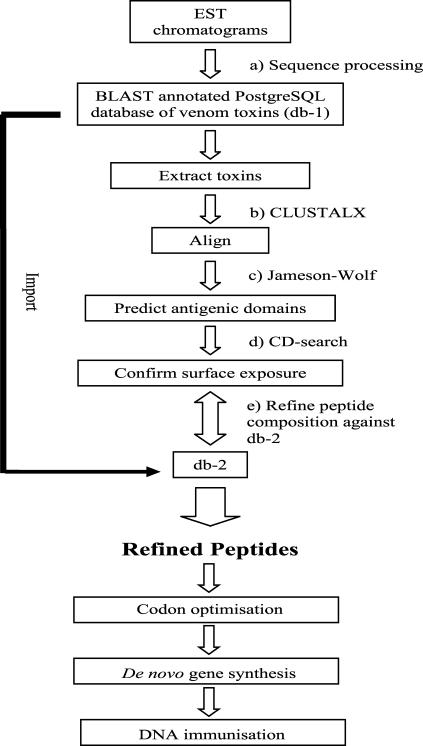
The Bioinformatic Pipeline Used to Identify Immunogenic PeptidesEST chromatograms (A) are trimmed for contaminating sequences by trace2dbest, imported into PartiGene [
25], clustered using CLOBB [
26], BLAST-annotated, and finally used to populate db-1. Toxins are extracted and aligned using CLUSTALX (B) before (C) antigenic predictions by Jameson-Wolf (C) and three-dimensional superposition using CD-search (D). Peptide composition was refined against db-2 (E) before sequence incorporation into synthetic codon optimized DNA constructs for immunization (db, database).